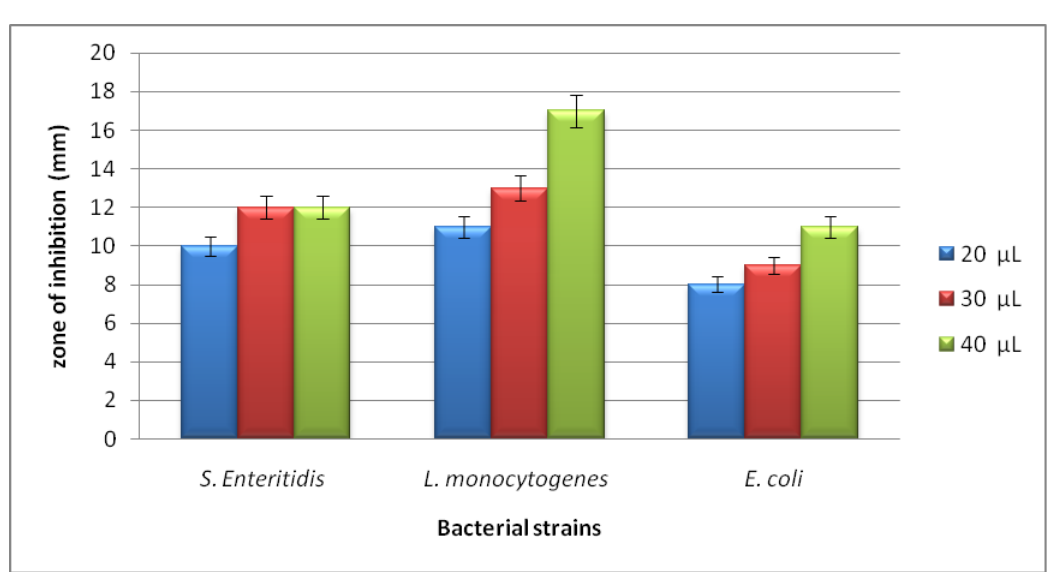
Figure 2. Zone of inhibition (mm) due to different concentrations (20, 30 and 40 µL) of P. cordaeana methanol extract against the bacterial strains of S. Enteritidis 155 , E. coli 555 and L. monocytogenes 56Ly . Column height represents the mean of triplicate results and error bar represents the range of the results.